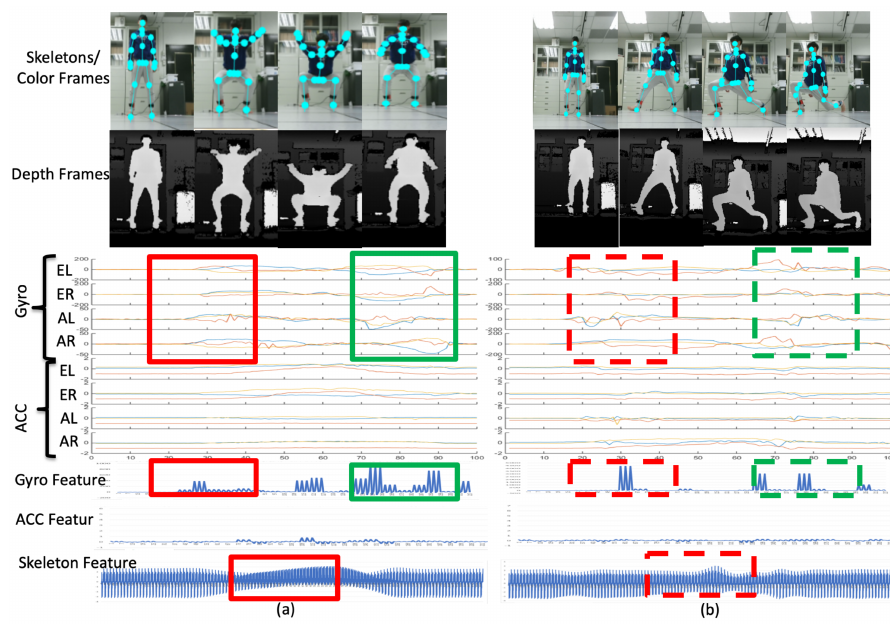
Figure 16. Representations of ( a ) the deep squat motion and ( b ) the left lunge motion.